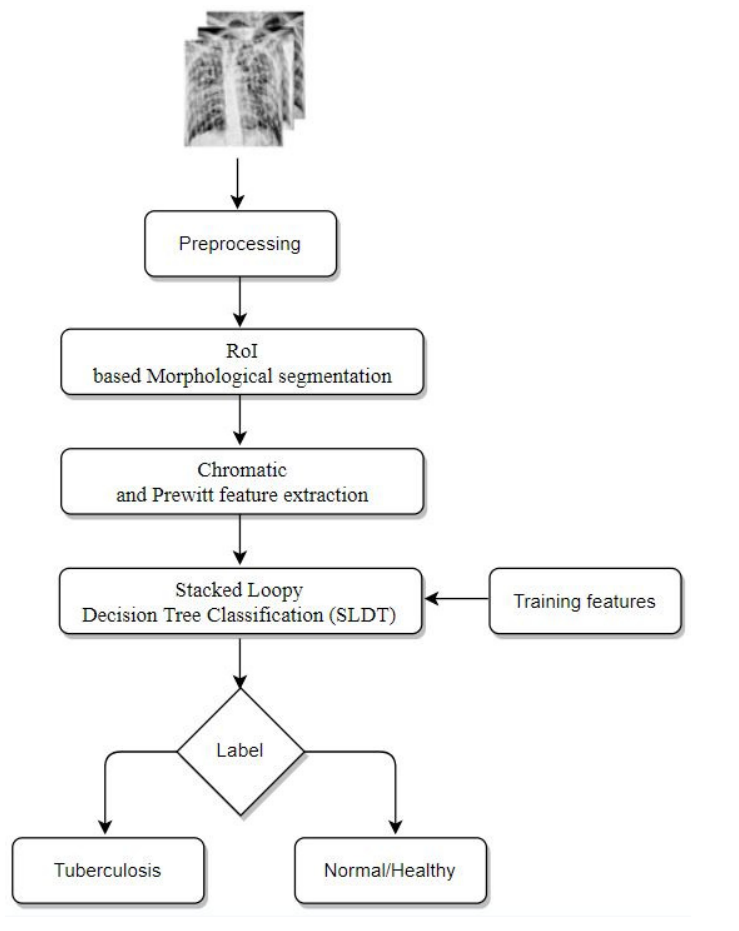
Figure 1. Block diagram of the proposed method.